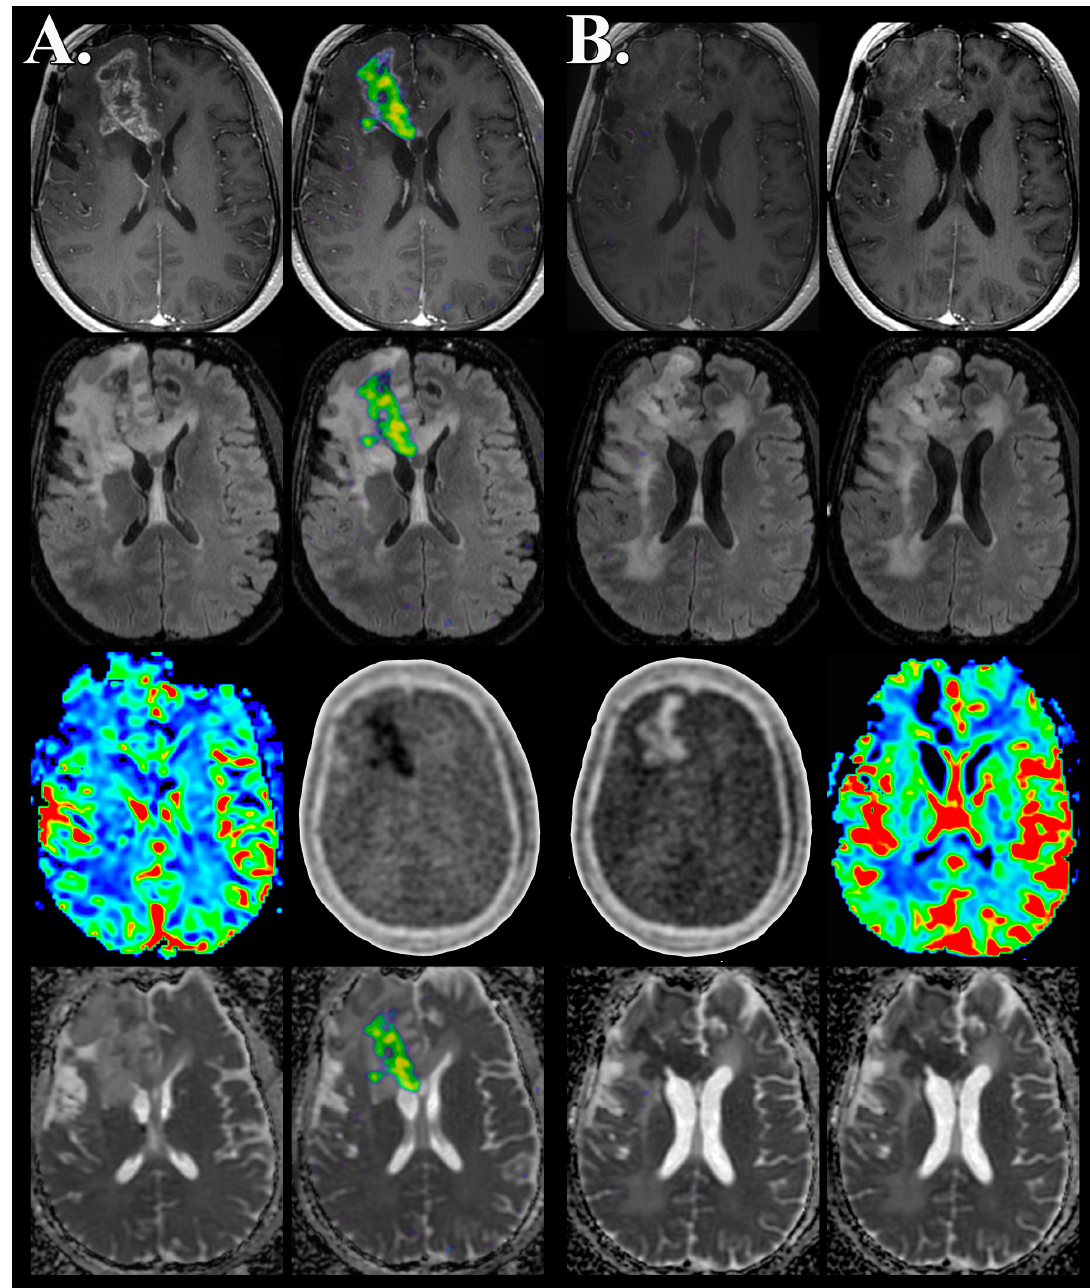
Figure 2. Absent FMISO hypoxic volume with associated development of reduced diffusion in recurrent high grade glioma concurrent with bevacizumab therapy. FMISO PET/MR imaging obtained simultaneously 5 days prior to ( A ) and 100 days following antiangiogenesis therapy ( B ) demonstrates progression of recurrent disease characterized by increased volume of nonenhancing mass (contrast, top row; FLAIR, top middle row) associated with the development of reduced diffusion (adc map, bottom row). Fused FMISO PET imaging (baseline, middle left; follow-up, middle right) demonstrates the resolution of tumor hypoxia concurrent with antiangiogenesis therapy. The unprocessed FMISO PET image (baseline, middle left; follow-up, middle right; bottom middle row) demonstrates the marked decrease in radiotracer accumulation below background tissue levels within regions of preserved cerebral blood volume (baseline, left; follow-up, right; bottom middle row) suggesting tissue consisting of highly cellular recurrent tumor with transformed or normalized tumor microvasculature.